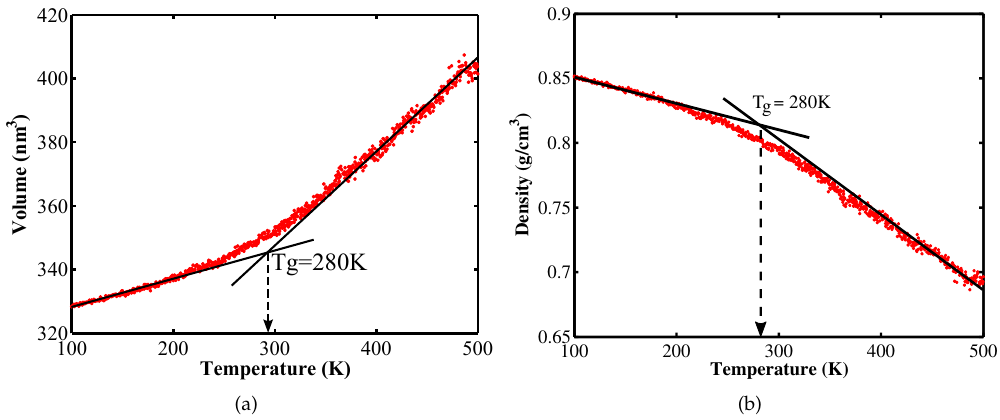
Figure 2. The change in specific volume ( a ) and density ( b ) as a function of temperature.